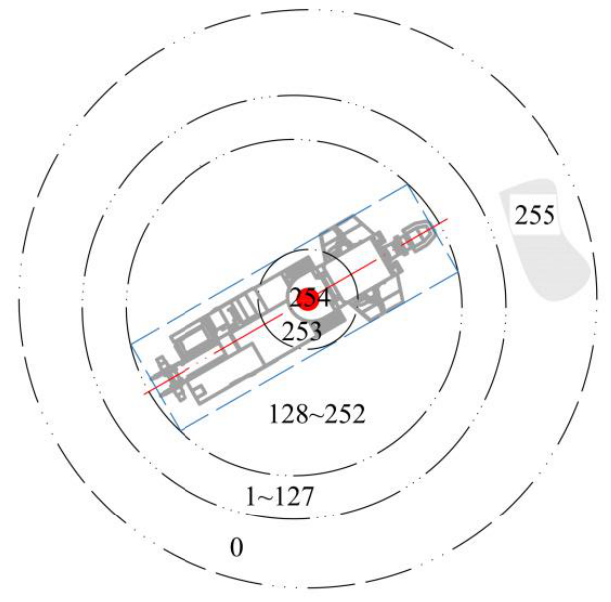
Figure 9. Value principle of cost map.